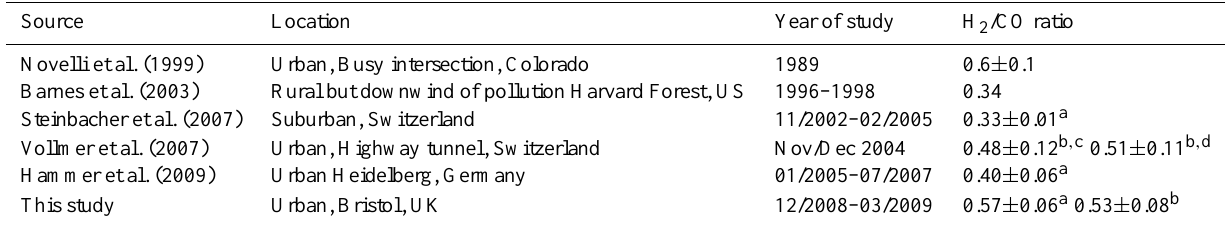
Table 1. Literature comparisons of molar H 2 /CO ratios calculated from linear